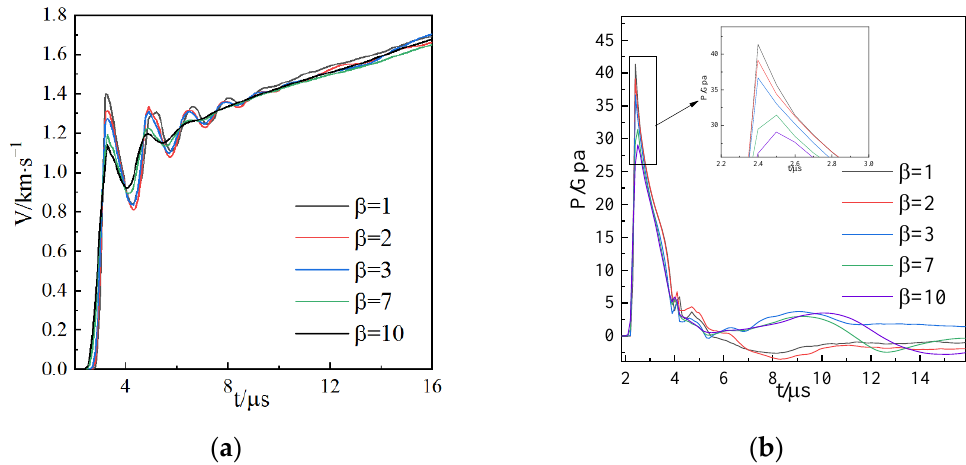
Figure 4. Comparison of data from different models: ( a ) velocity of the outer wall of the cylindrical shell and ( b ) internal hydrostatic pressure.